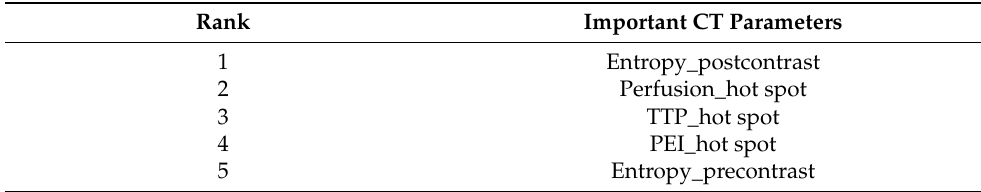
Table 6. Top five important CT parameters from the integrated random forest model to predict histological biomarkers and molecular subtypes.